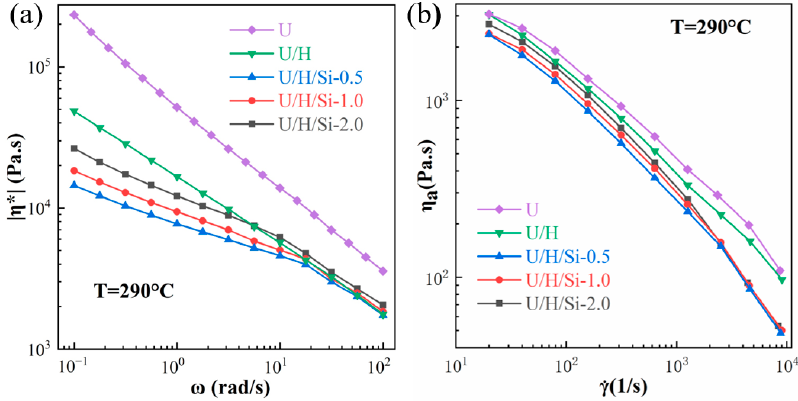
Figure 3. Rheological property of samples: ( a ) complex viscosity ( |𝜂 ∗ | ); ( b ) apparent viscosity ( 𝜂 (cid:3028) )